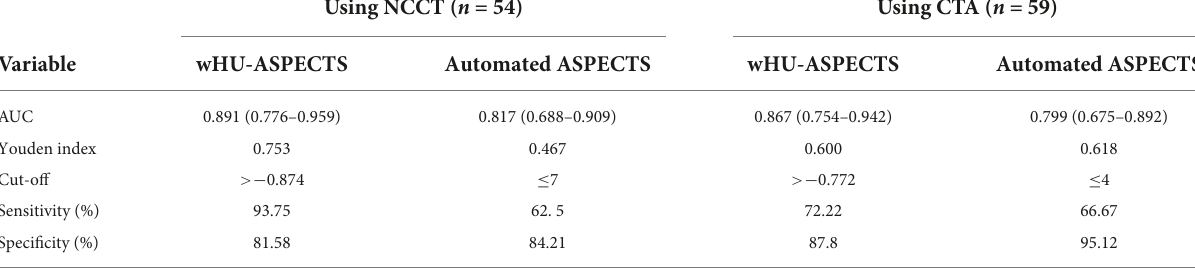
TABLE 3 ROC analysis of attenuation changes and automated ASPECTS for classification of ischemic core ≥ 70 ml. Using NCCT ( n = 54)